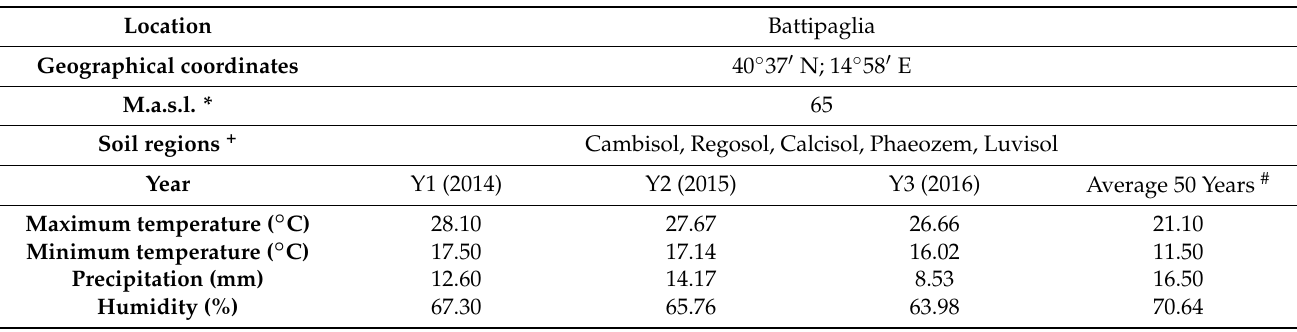
Table 2. Geographic coordinates, pedological characteristics, and climatic conditions of the cultivation environments of the present study. For temperature, precipitation, and humidity, the mean values of the grown season of each year (April–August) are